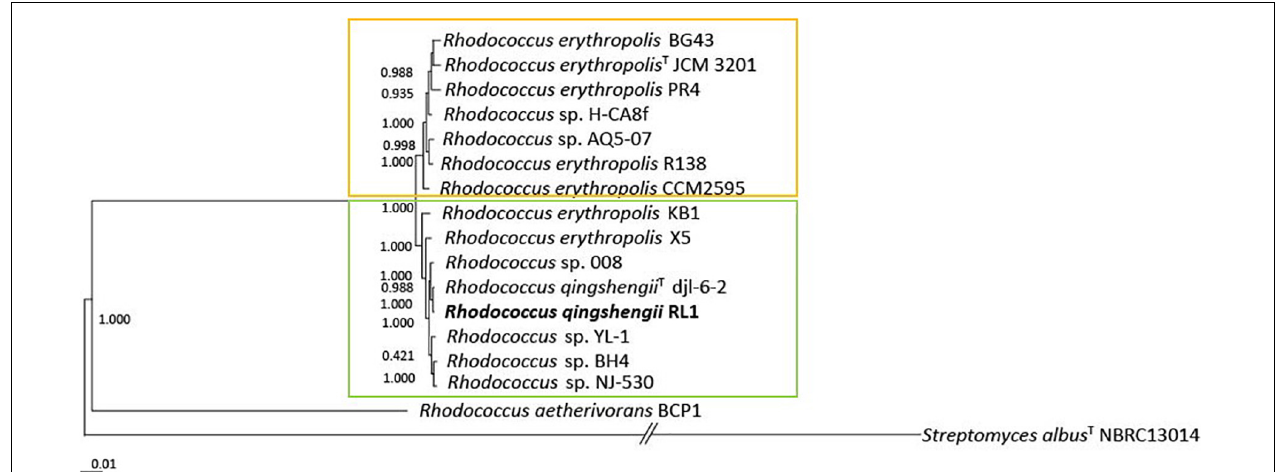
FIGURE 1 | Maximum-likelihood phylogenetic tree of 15 genomes of the Rhodococcus erythropolis clade generated with FastTree 2.1 from 1211 nucleotide sequences of the core genome. Values represent local support values based on Shimodaira–Hasegawa test (1 SH = 100% bootstrap). The scale bar represents